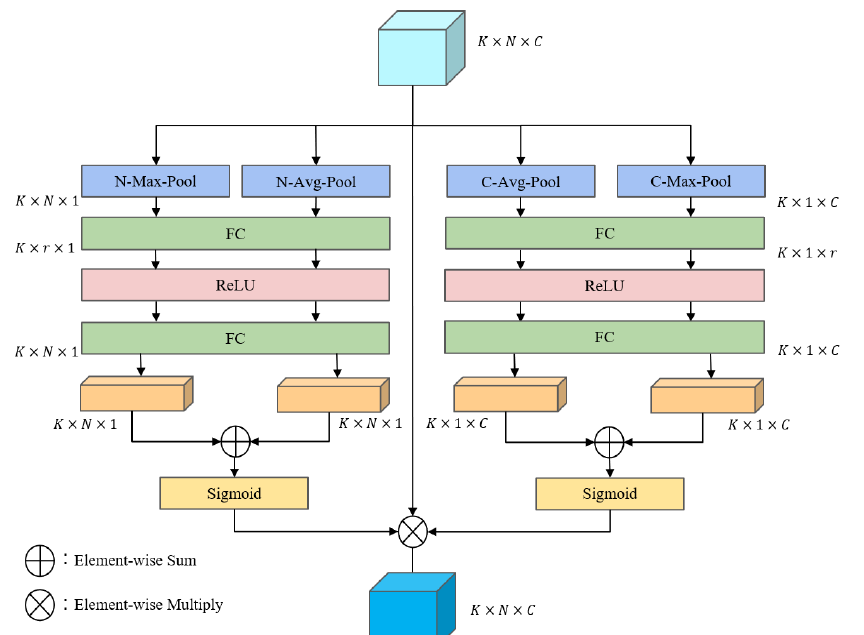
Figure 2. The structure of the point-channel attention